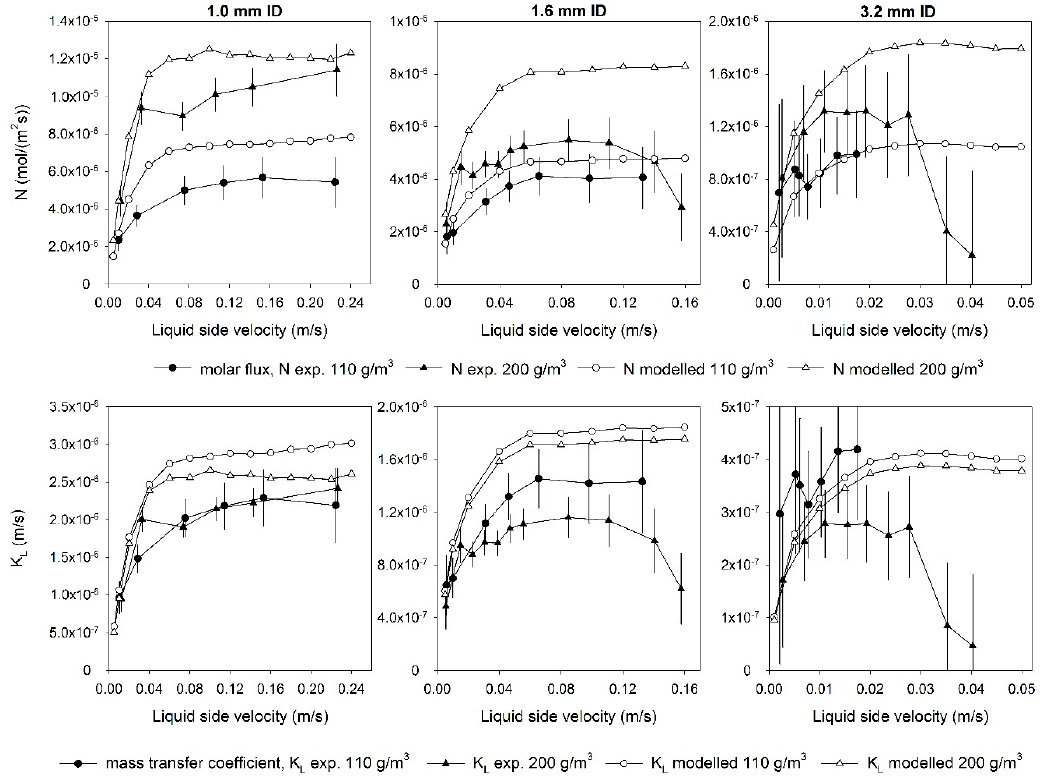
Figure 3. Experimental and modelled overall mass transfer coefficients K L and molar fluxes of ozone N in pure water at ozone gas concentration of 110 g/m 3 and 200 g/m 3 versus liquid side velocity.To